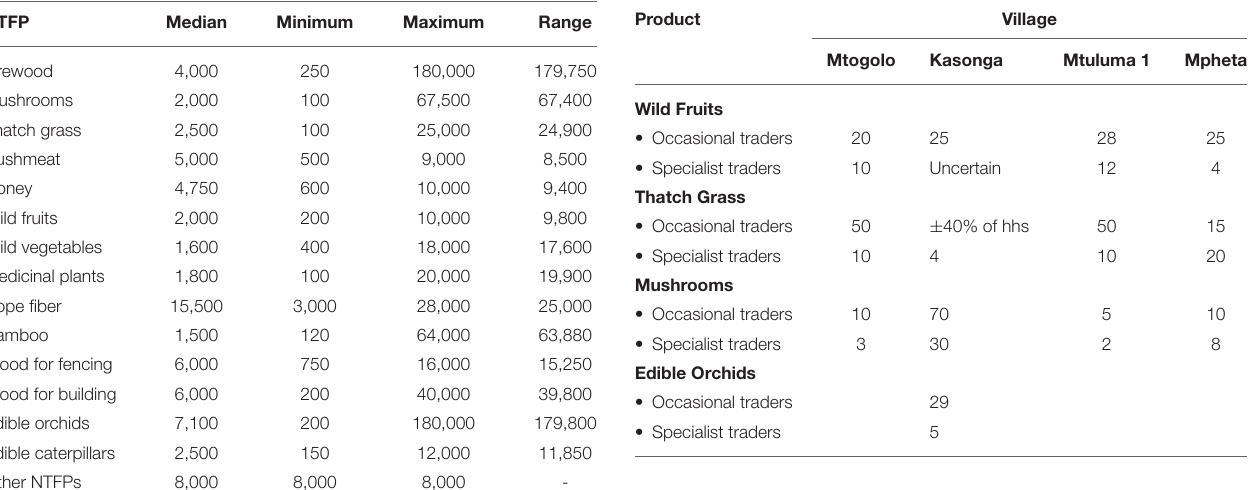
TABLE 4 | Total annual income per NTFP to selling households (Mk/year; US$1 = Mk395). NTFP